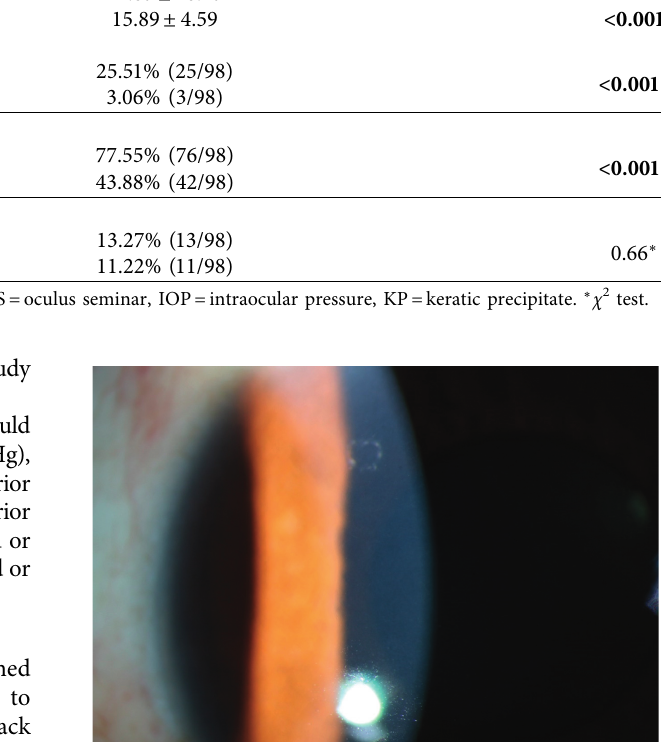
Figure 1: Coin-shaped KP under a slit lamp. Color photograph of the left eye of a 40-year-old female patient with a 2-year PSS course. A typical coin-shaped KP can be seen in the upper half of the photograph and disappeared after 2% ganciclovir eye drops application.